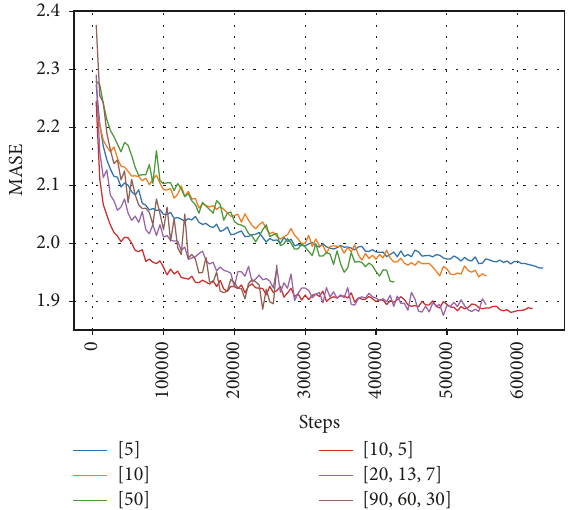
Figure 5: Trend in MASE for different FNNs with a sigmoid activation function.